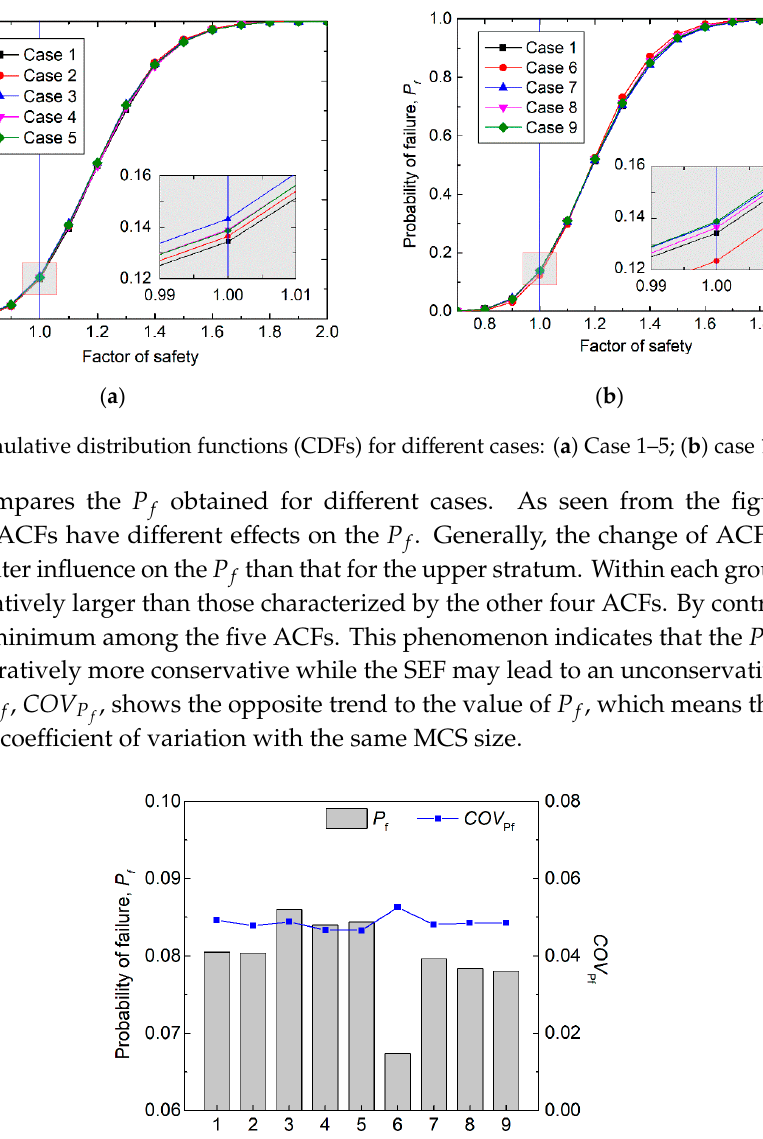
Figure 4. Histograms and fitted probability distribution functions (PDFs) of factor of safety (FS) for different cases.